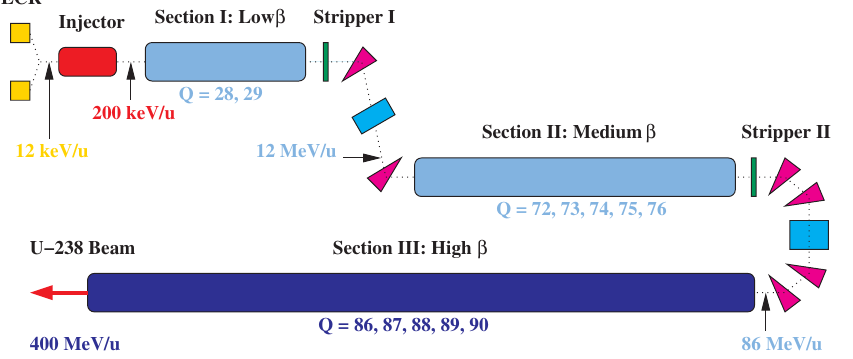
FIG. 1. (Color) Schematic of the RIA driver linac. The indicated charge states and energies corresponds to a U 238